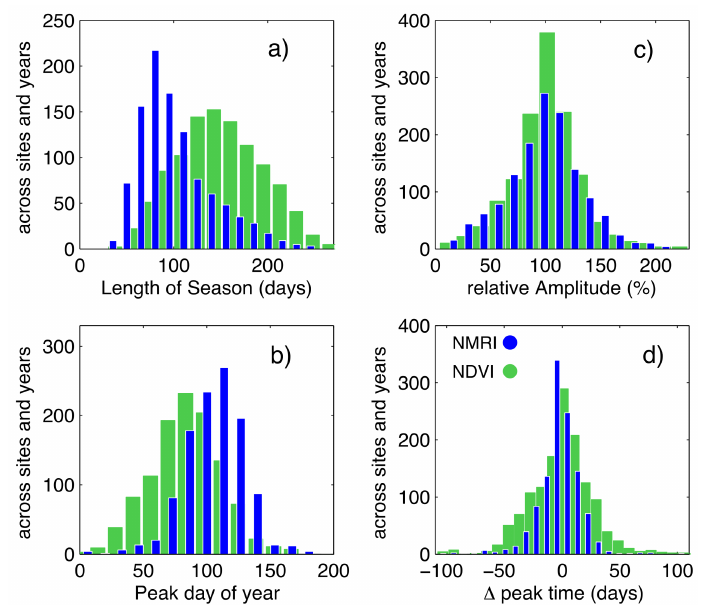
Figure 4. Histograms of ( a ) Length of season; ( b ) Mean peak day of year; ( c ) Relative amplitude; and, ( d ) Deviation from the mean peak day of year. Histograms are for all sites over all